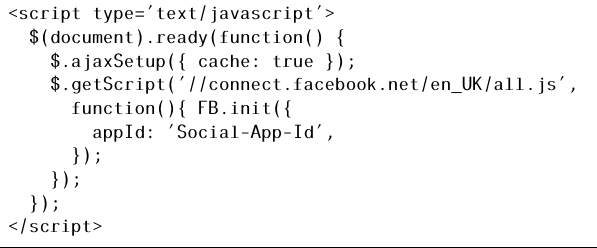
Figure 14. Facebook JS-SDK load